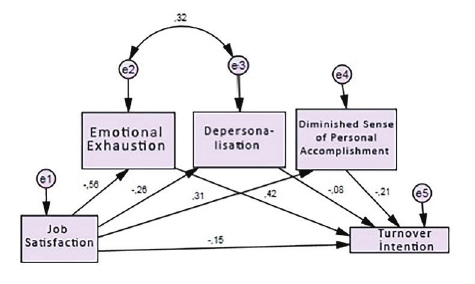
Figure 1 - Structural Equation Model for the nurses’ job satisfaction, burnout, and turnover intention